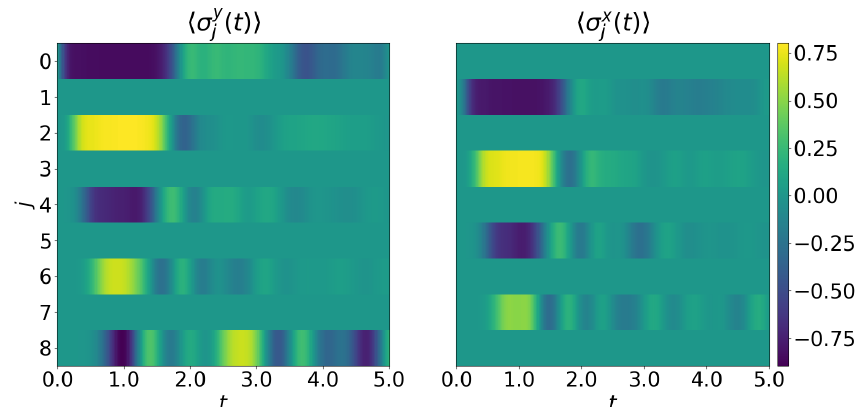
Figure 3: A space-time diagram of the Y (left) and X (right) Pauli observables of nine qubits in a 1D chain as in Fig. 1, in the same simulation as in Fig. 2. It can be seen that with qubit 0 being driven about its x axis, its X expectation value remains identically 0, while in 〈 Y 〉 it quickly settles to a large negative value, nearly constant for a relatively long time – until the signal reflecting back from the chain right edge returns. The angle of the single-qubit projection in x y plane changes by − π/ 2 be- tween neighboring qubits along the